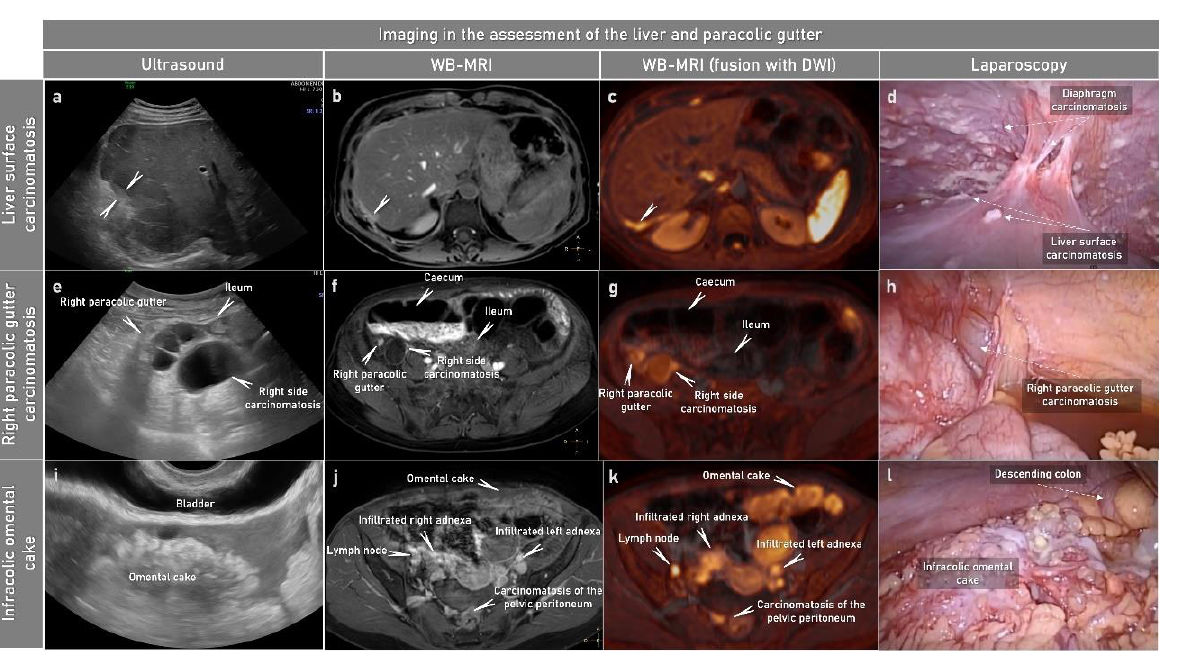
Figure 4. Characteristic imaging and laparoscopy findings in patient with high-grade serous cancer FIGO stage IVB. Abdominal convex array ultrasound (first column), axial WB-MRI: CE-T1WI-FS (contrast enhanced T1 weighted imaging with fat suppression) (second column) and WB MRI fused with DWI: DWIBS (diffusion-weighted imaging with background body signal suppression) + CE- T1WI-FS (third column) and laparoscopy findings (fourth column). The imaging findings confirmed by laparoscopy indicate visceral hepatic carcinomatosis marked with arrow outline ( a – d ), mainly cystic carcinomatosis in the lower part of right paracolic gutter ( e – h ) and omental cake ( i – l ). CE, contrast-enhanced; DWI, diffusion-weighted imaging; FIGO, International Federation of Gynecology and Obstetrics; FS, fat suppression; WB-MRI, whole-body magnetic resonance